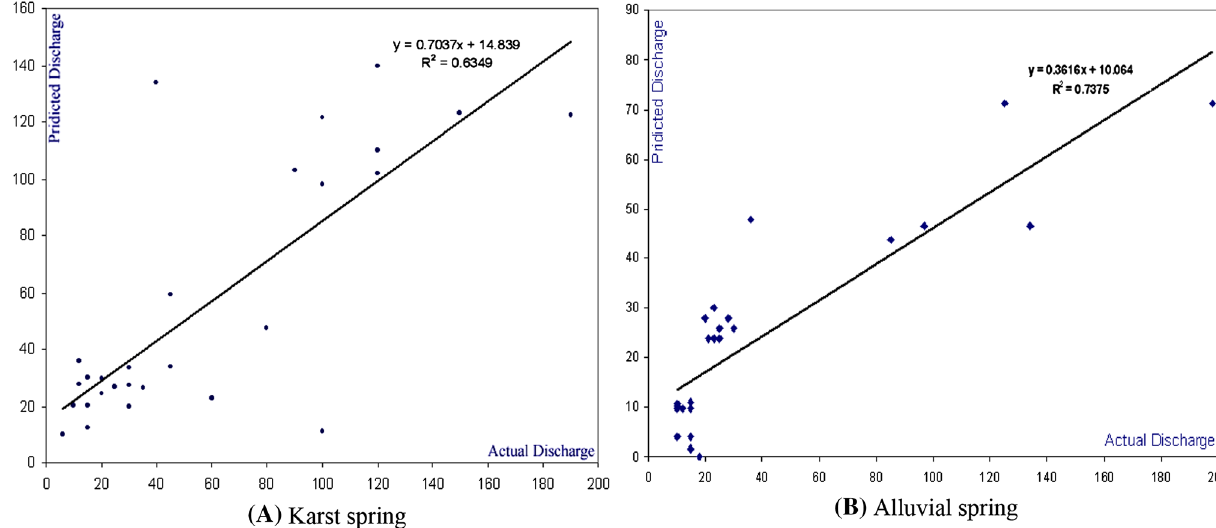
Fig. 4 Evaluating the linear model’s efficiency in estimating the springs discharge